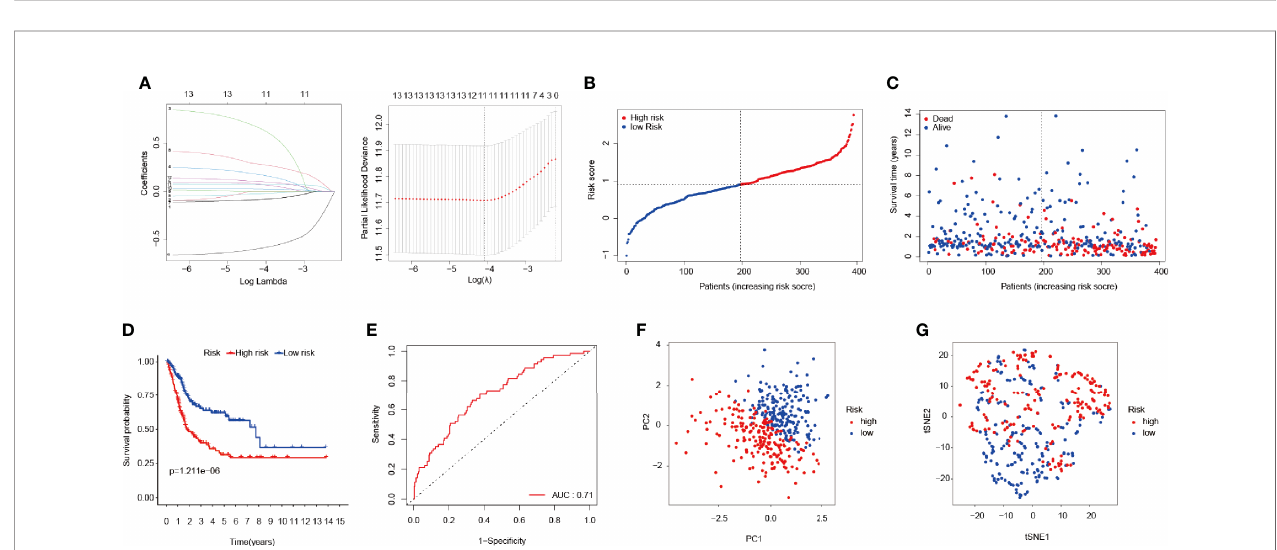
FIGURE 3 | Construction of the FRPM. (A) LASSO Cox regression model applied to screen key genes, and partial likelihood deviance with 10-fold cross-validation was utilized to calculate the best lambda. (B) Distributions and median value of the risk scores in BLCA patients. (C) Distributions of the survival status values. (D) Kaplan-Meier curves for the seven genes relative to the overall survival outcomes. (E) AUC of the time-dependent ROC curve showing the predictive ef fi ciency. (F, G) PCA plot and t-SNE